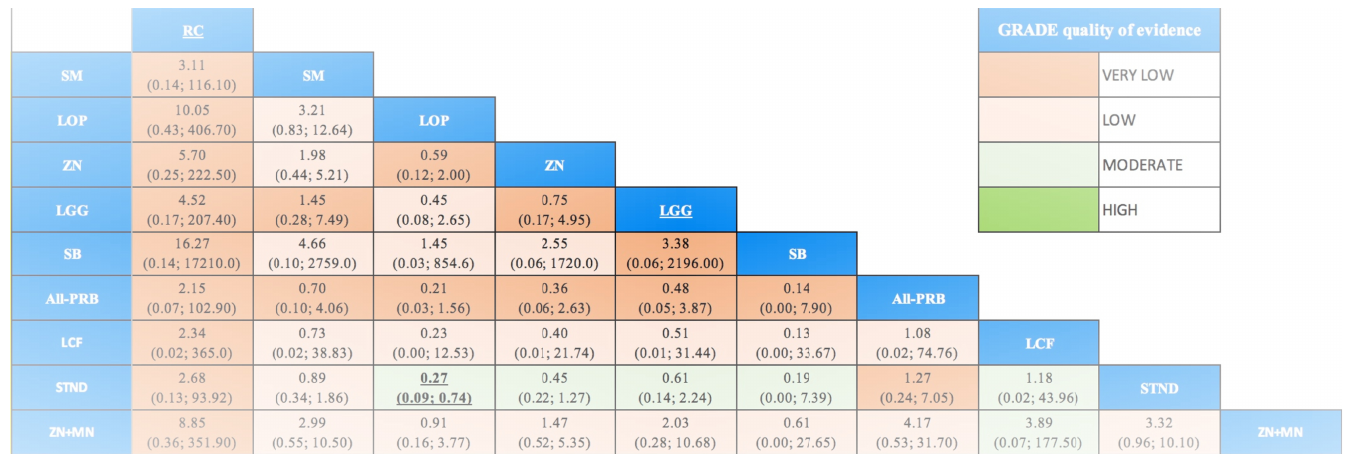
Fig 6. League table with NMA estimates for side effects. Comparisons should be read from left to right. The effectiveness estimate is located at the intersection of the column-defining treatment and the row-defining treatment. Side effects estimates are presented in odds ratio (OR) with the 95% CrI, an OR below 1.0 favors the row- defining treatment (less presence of side effects). To obtain ORs for comparisons in the opposing direction, reciprocals should be taken. Significant results are in bold and underlined. Cells filling represent the GRADE quality of evidence assessment: Green: High quality; Light Green: Moderate quality; Light Orange: Low; Darker Orange: Very Low. OR: Odds Ratio; 95CrI%: 95% Credible Intervals. Interventions’ abbreviations are described in Table 1.